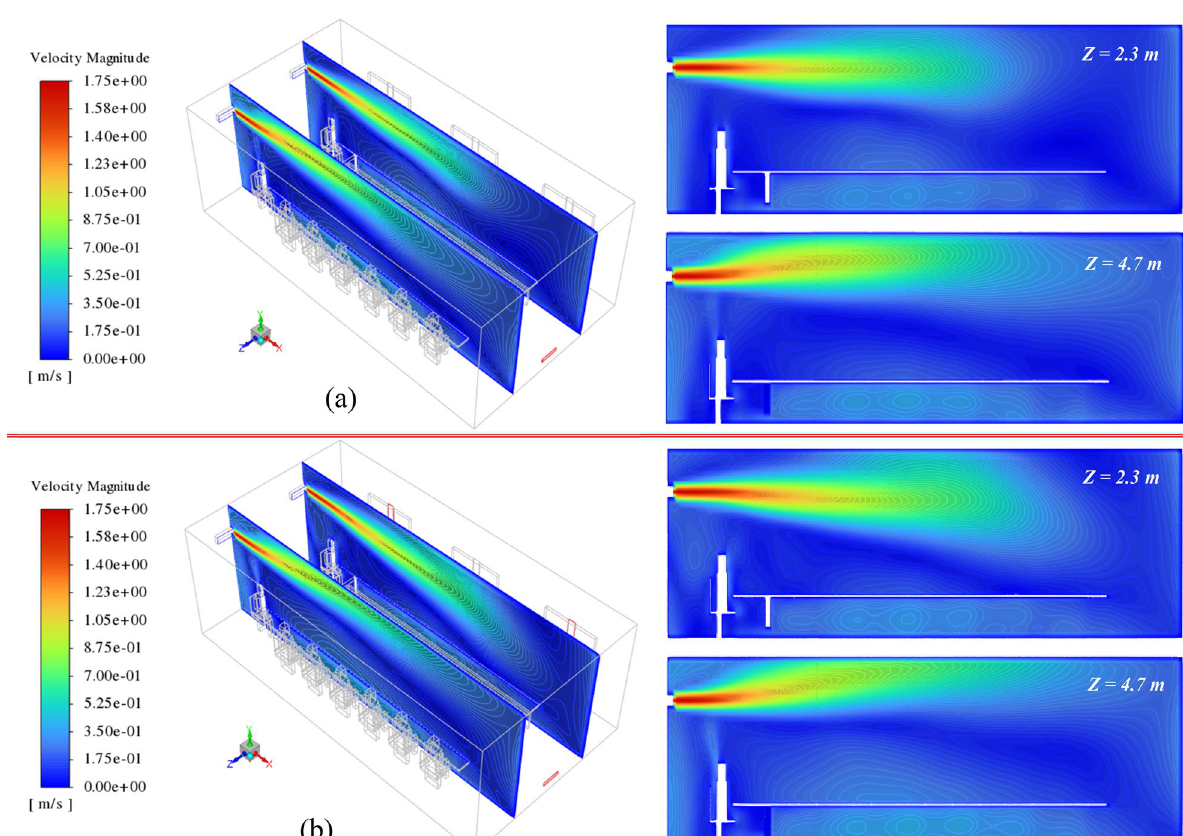
Figure 6. Velocity contour of indoor airflow at z = 2.3 and 4.7 m on the isometric view (left side) and XY plane (right side), for ( a ) all the windows, be closed, and ( b ) windows 1 and 3 be